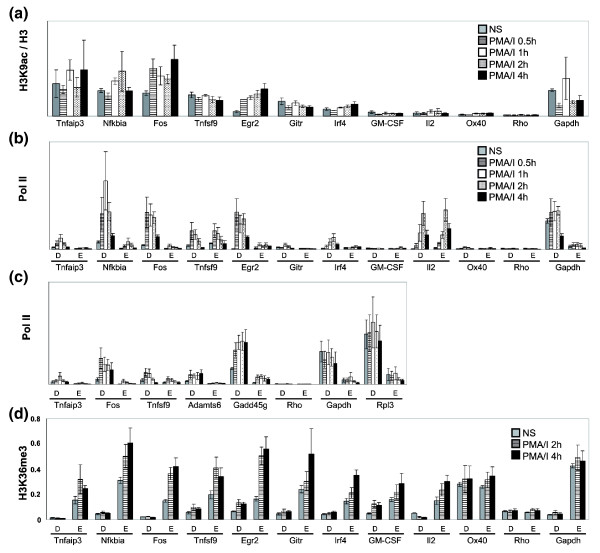
Changes in H3K9ac, Pol II and H3K36me3 upon stimulation of EL-4 T cells. (a) ChIP assays were performed with antibodies against H3K9ac using unstimulated EL-4 T cells (grey bars), and cells that were stimulated with P/I for 0.5 h (hatched bars), 1 h (white bars), 2 h (dotted bars) and 4 h (black bars). The data for the promoter region of each gene are presented as a ratio of H3K9ac/H3 levels. The mean and standard error of at least three independent experiments are shown. (b, c) ChIP was performed with antibodies against the CTD repeat of Pol II using unstimulated EL-4 T cells (grey bars), and cells that were stimulated with P/I for 0.5 h (lined bars), 1 h (white bars), 2 h (dotted bars) and 4 h (black bars). The data are presented as a ratio of immunoprecipitated DNA to the total input DNA and show Pol II occupancy for the promoter region (primer set D) and 2 kb downstream of the TSS (primer set E). The mean and standard error of three independent experiments are shown for each primer set. (d) A ChIP assay was performed with antibodies against H3K36me3 using unstimulated EL-4 T cells (grey bars), and cells that were stimulated with P/I for 2 h (lined bars) and 4 h (black bars). The data are presented as ratios of immunoprecipitated DNA to the total input DNA and shows H3K36me3 occupancy at the promoter region (primer set D) and 2 kb downstream (primer set E). The mean and standard error of four independent experiments are shown. PMA, phorbol myristate acetate.